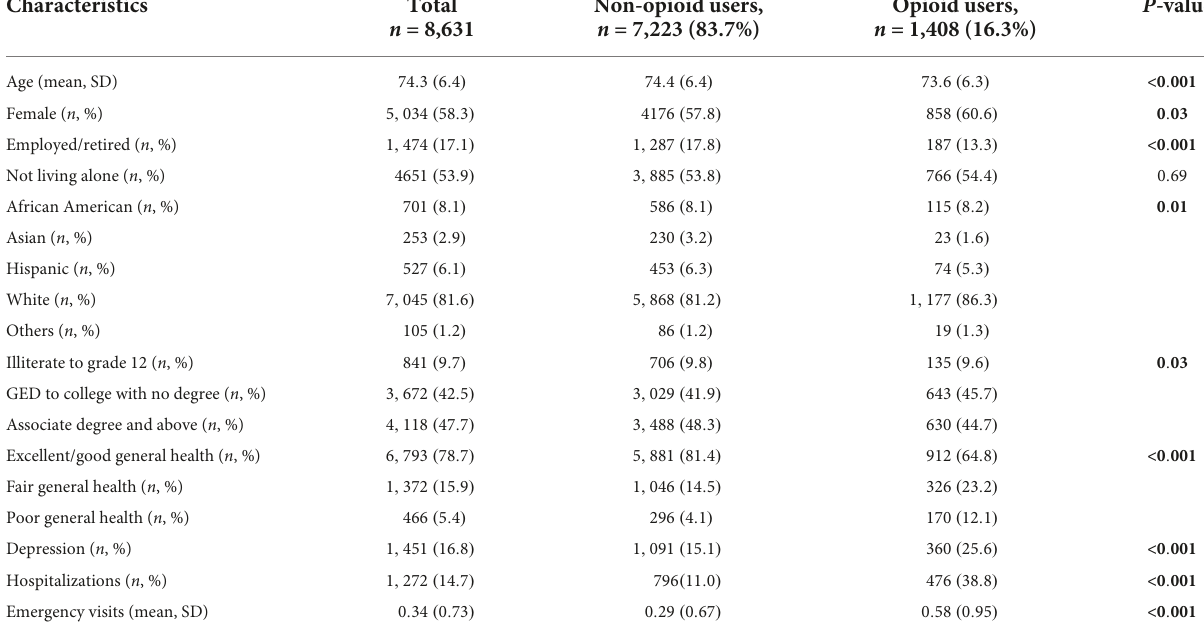
TABLE 1 Participant’s sociodemographic and health